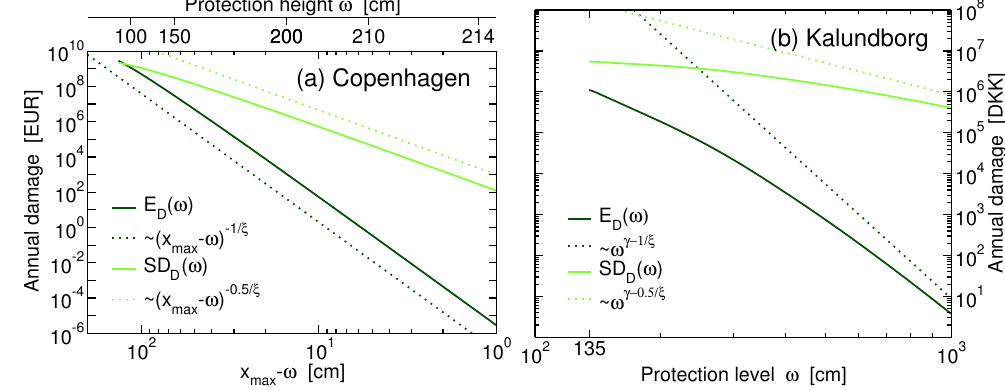
Figure 6. Expected annual damage (dark green) and standard deviations (light green) in (a) Copenhagen and (b) Kalundborg as a function of the protection level ω . The abscissa in the left panel is inverted and shows the difference between the protection level ω and the maximum possible water level x max = 215 . 28cm (at the top, the corresponding protection heights are displayed). Since no considerable damage occurs in Kalundborg for sea levels below 135cm, only protection levels above ω = 135cm are considered. The dotted lines follow the power laws from Eqs. (15) and (16) with the estimated damage function exponents γ = 1 . 6 (Copenhagen) and γ = 4 . 1